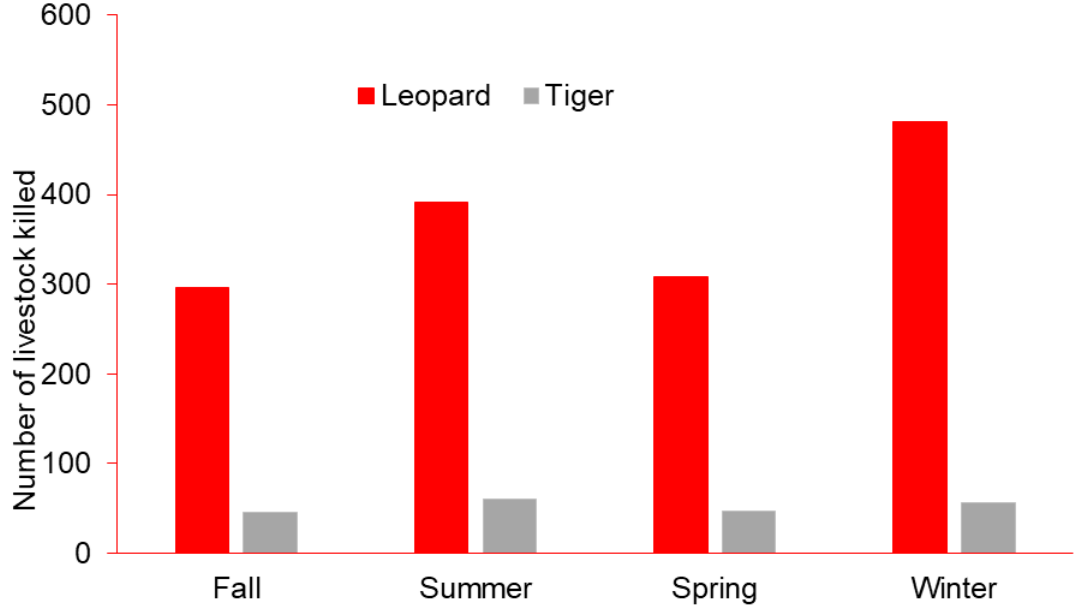
Figure 2. Number of livestock depredations by leopards and tigers seasonally near Bardia National Park, Nepal, 2015–2019.